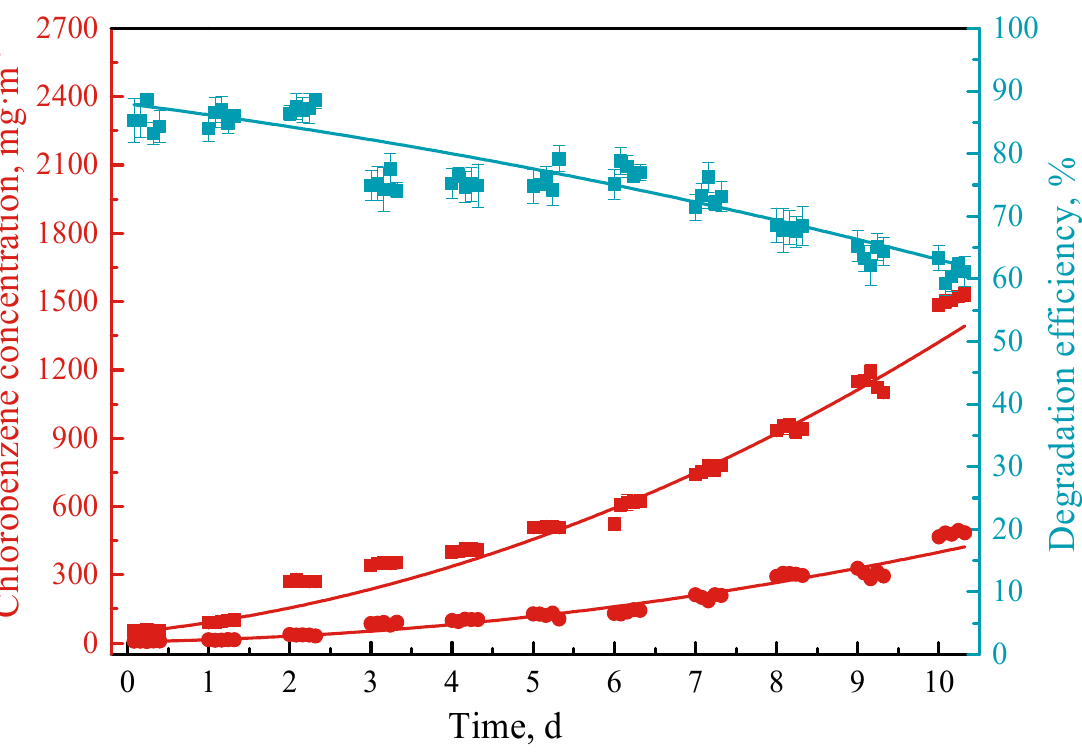
Figure 4. The degradation efficiency of chlorobenzene under different chlorobenzene concentra- tions. Liquid Rate = 5.17 m 3 ·m − 2 ·h − 1 , EBRT = 48 s, pH = 6.5–7.0, Oxygen Concentration = 10%. ■ Deg- radation efficiency ■ Inlet concentration ● Outlet concentration.